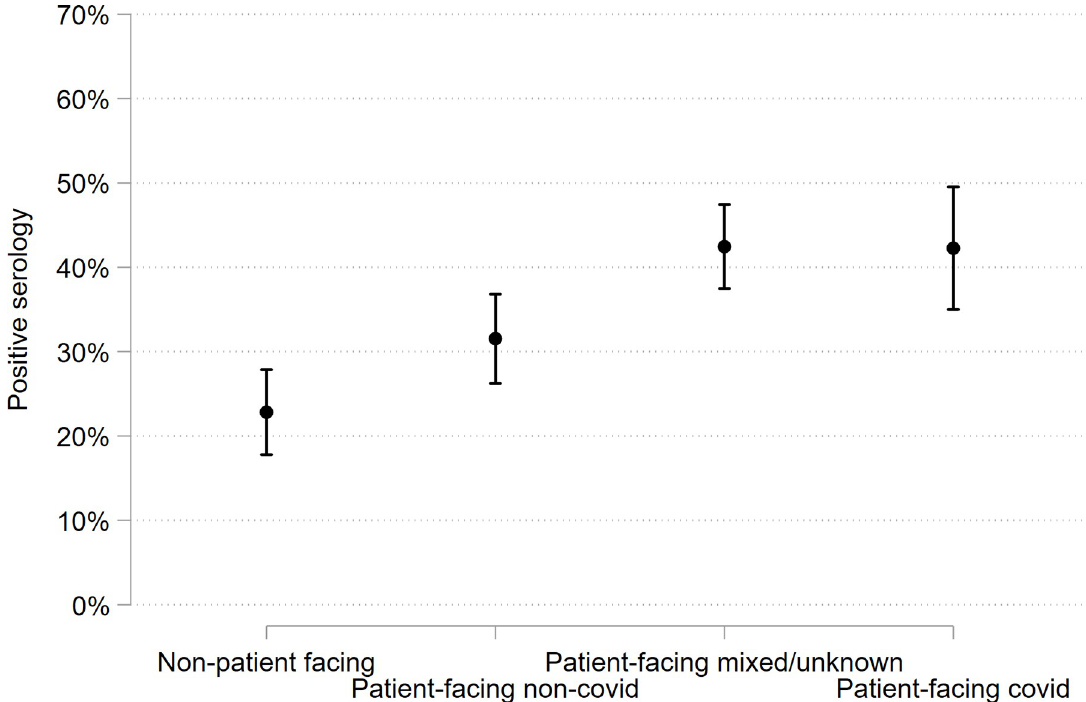
Fig 1. Adjusted predicted probabilities of infection for the patient facing variable using different patient-facing groupings where these are adjusted for age, gender, BAME, public transport and household contacts. Non patient-facing cohort compared to all patient-facing subcategories.